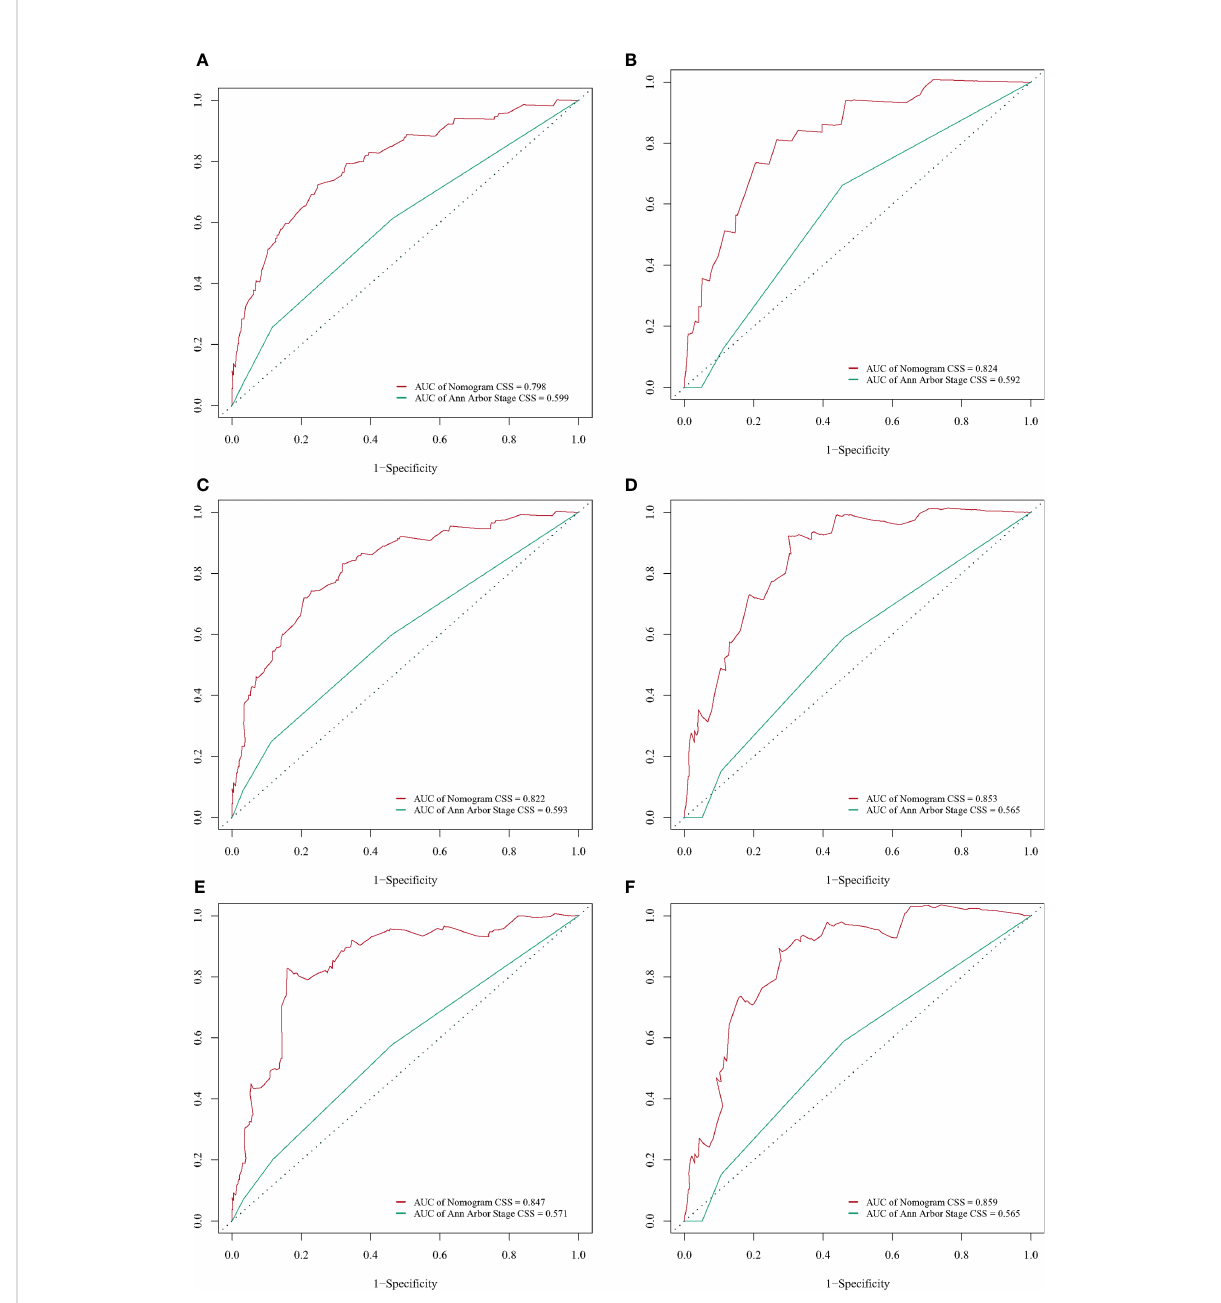
FIGURE 4 Receiver operating characteristic (ROC) curves for predicting BC-PTML-speci fi c survival at 5-, 10-, and 15-years in the training (A, C, E) and validation (B, D, F)